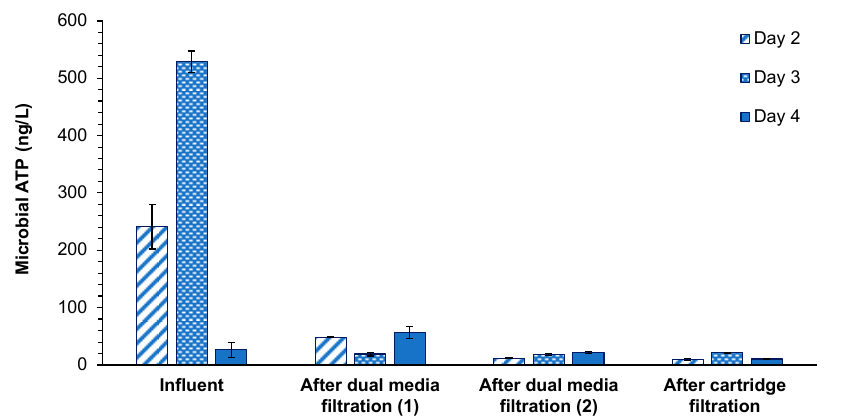
Figure 3. Microbial adenosine triphosphate (ATP) concentrations during the reverse osmosis pre- treatment processes of the SWRO desalination plant. Chlorination was applied on day 4.